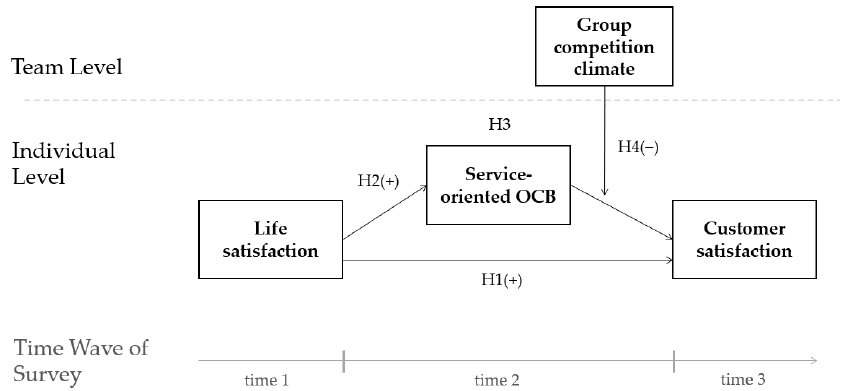
Figure 1. A Conceptual Model of the Hypotheses.